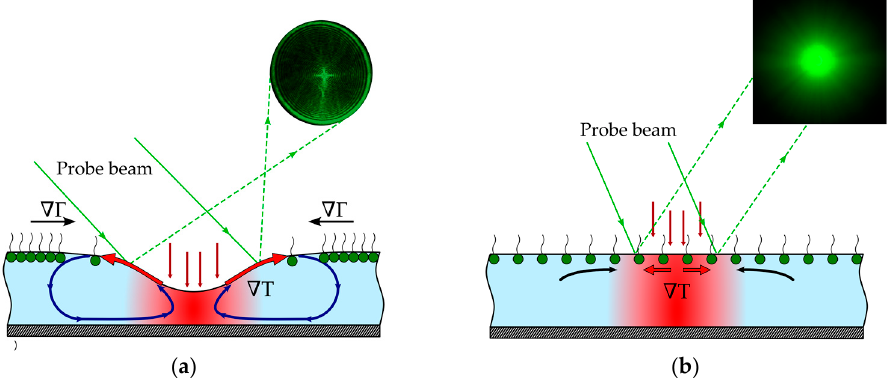
Figure 4. Schematic of the laser-induced thermocapillary convection in a layer with surfactants on the liquid–air interface. ( a ) The competition between interfacial forces caused by thermal gradient and interfacial forces caused by surfactant concentration gradient (the concentration-driven Marangoni flows); ( b ) an increase of surface concentration of surfactant molecules suppresses the laser-induced thermocapillary flows and interfacial deformation. This leads to disappearing the PTC signal on a screen.